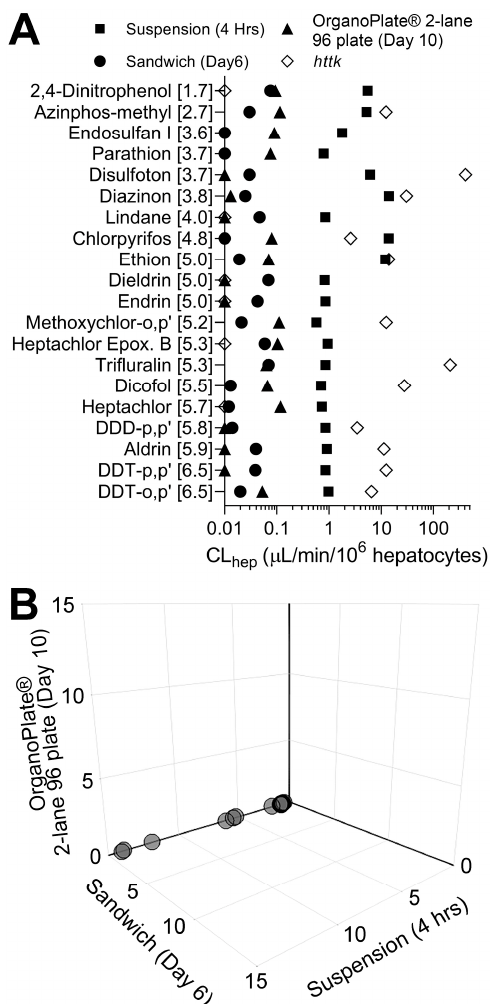
Figure 3. ( A ) In vitro hepatocyte clearance of chemicals in suspension culture (squares), sandwich culture (circles), OrganoPlate ® 2-lane 96 (triangles), and httk (diamonds). Plotted are in vitro hepato- cyte clearances (mean) of each chemical listed (the number in brackets indicates the LogP of each compound). Experiments were conducted using induced pluripotent stem cell-derived hepatocytes